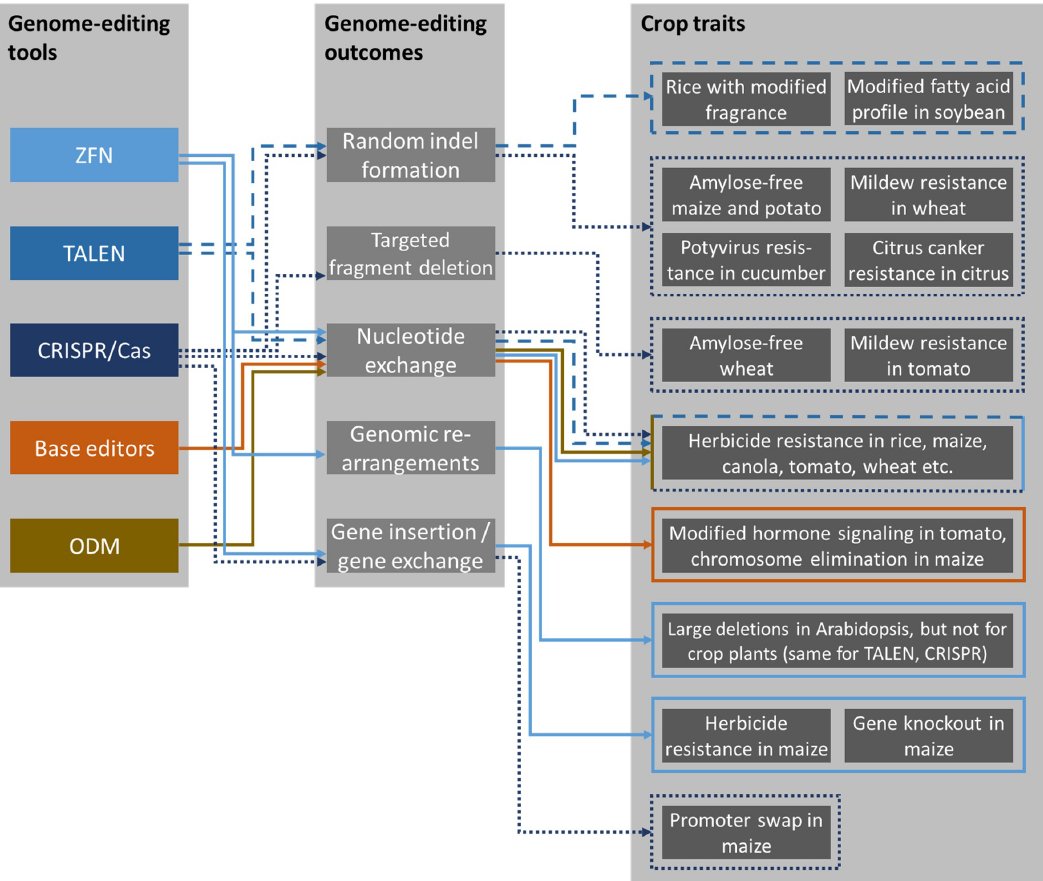
Figure 1. Overview of genome-editing tools, the possible genetic outcomes in each case, and examples of crop traits generated using these tools. The colored arrows and boxes link published crop trait examples with the associated genome-editing tool and outcome.